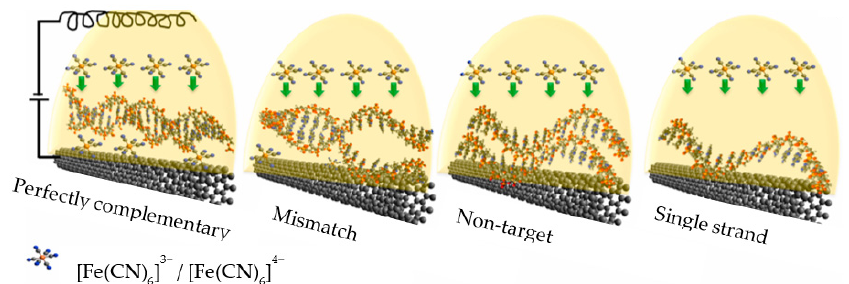
Figure 15. Visualization of the mechanism of CNTs interactions with different DNA forms, which are the basis of the impedimetric sensor. Adapted with permission from Prakash et al. [108] (copyright © (2021), Elsevier).